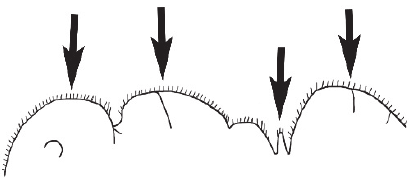
– Head and mesosoma not extensively covered with stout, peg-like bristles; Head, body and appendages covered in short, peg-like setae; cuticle strongly matt with coriaceous sculpture; posterior margin of head of all workers broadly concave; mandible of minor worker very finely striate, individual striae invisible under low power magnification (NSW, SA,